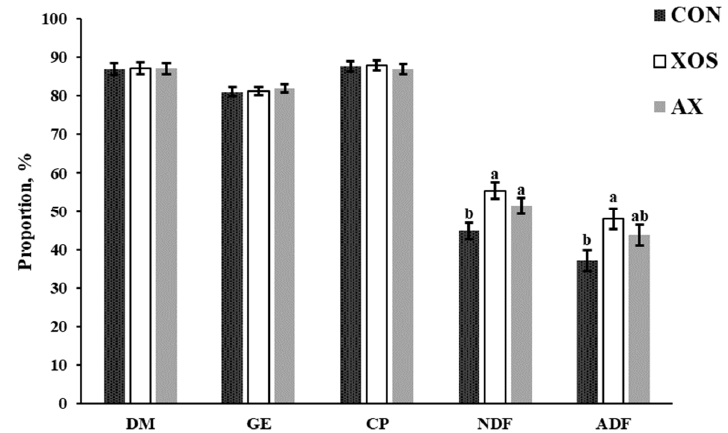
3.3. Effect of AX and XOS on Intestinal Morphology in Weaned Piglets